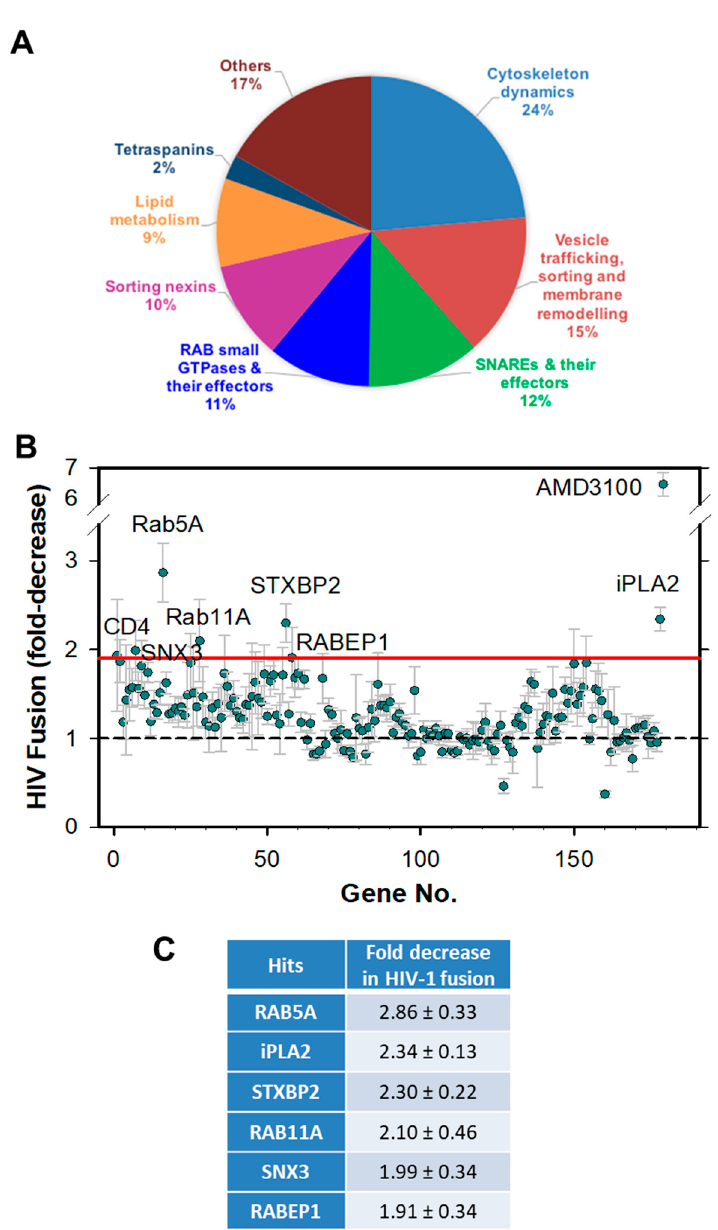
Figure 1. Targeted shRNA screen for factors facilitating HIV-1 fusion with CEM.CCR5 cells. ( A ) A pie-chart representation of the main gene families targeted by the shRNA screen. ( B ) Results of HXB2 pseudovirus-cell fusion (BlaM) assay using cells depleted of selected proteins. The results are plotted as fold-decrease in the fusion signal compared to that with cells transduced with a scrambled shRNA. The red horizontal line indicates the cut-off used to select hits. The data points are means and SD from quadruplicate wells. ( C ) A table showing the hits and the fold-decrease in HXB2 pseudovirus fusion.